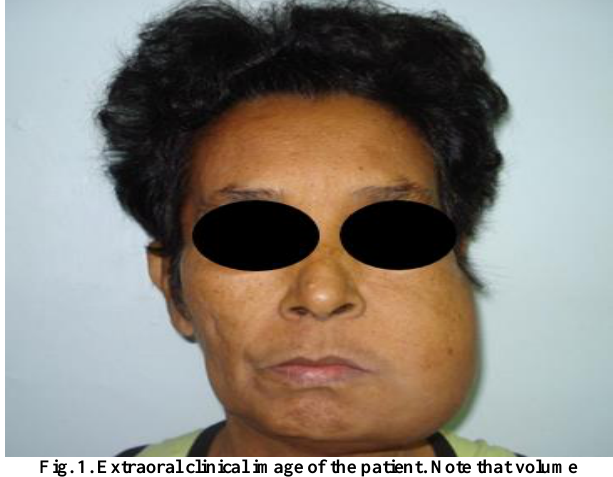
Fig. 1. Extraoral clinical image of the patient. Note that volume increases in the left buccal region, (published with the patient’s permission). There was evidence of trismus intraorally, exophytic, and erythematous lesions with pseudomembranous plaques in the left jaw alveolar flange (Fig.